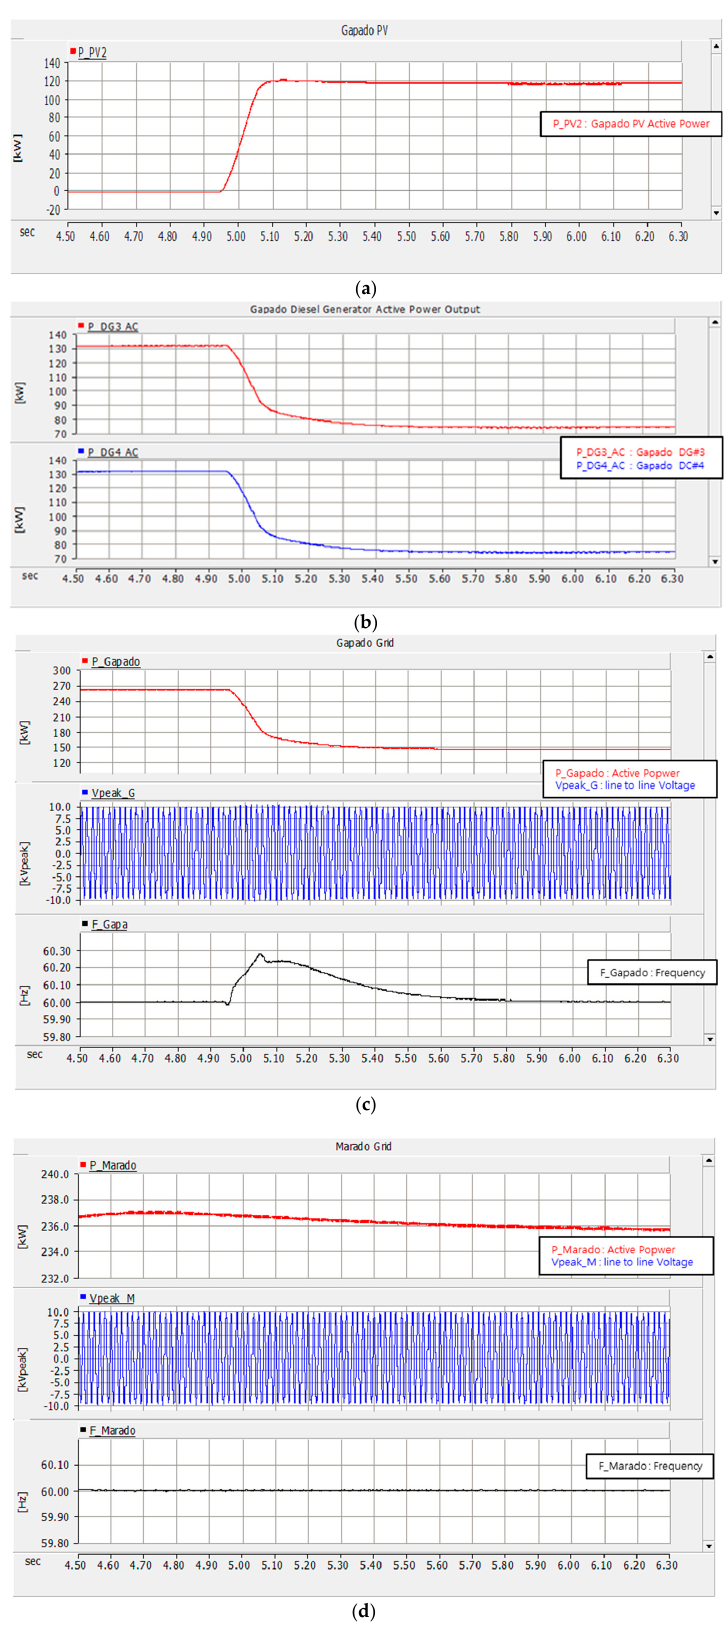
Figure 14. ( a ) Active power output of the grid; ( b ) Variation of active power output of the diesel generator; ( c ) Gapado Island power grid; ( d ) Marado Island power grid; through the PV penetration.